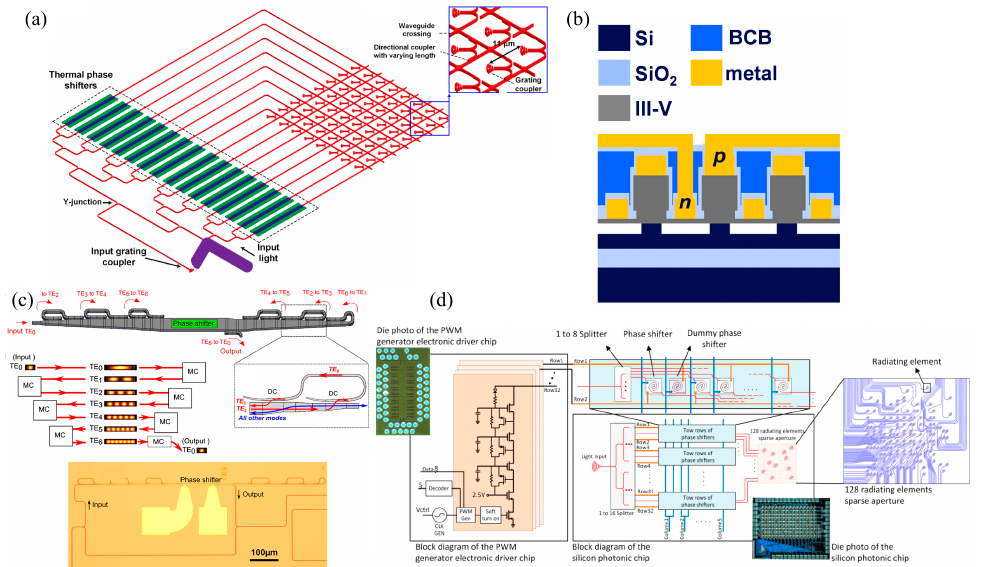
Figure 14. ( a ) An 8 × 8 OPA structure with 16 phase shifters placed outside of the array aperture. Reprinted with permission from [74] © The Optical Society. ( b ) Cross section of a III–V/Si phase shifter. Reprinted with permission from [126] © The Optical Society. ( c ) A multi-pass photonic structure based on mode multiplexing. Reprinted with permission from [103] © The Optical Society. ( d ) A two-chip solution OPA and die photos of fabricated chips. Reprinted with permission from the author of [143] © The Author(s).